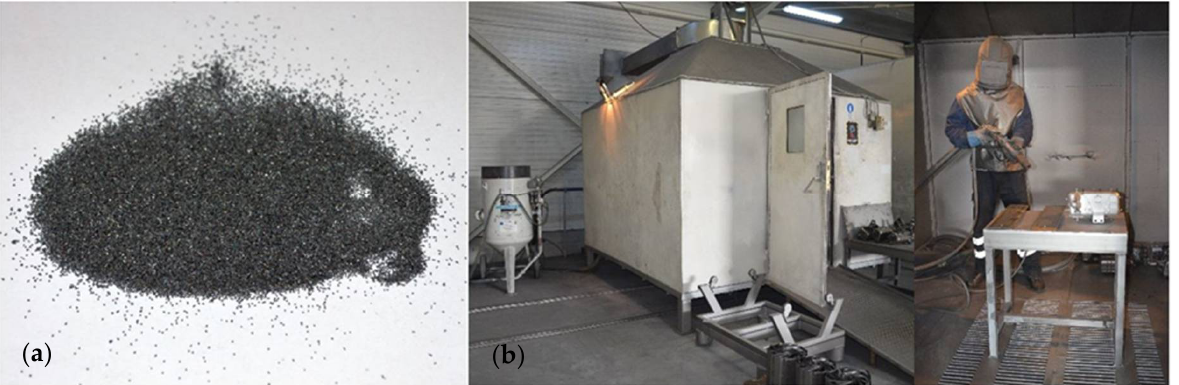
Figure 1. ( a ) GL-80 steel grits; ( b ) sandblasting chamber [28]. Table 4. GL-80 steel grits produced by W Abrasive [28]. Grading